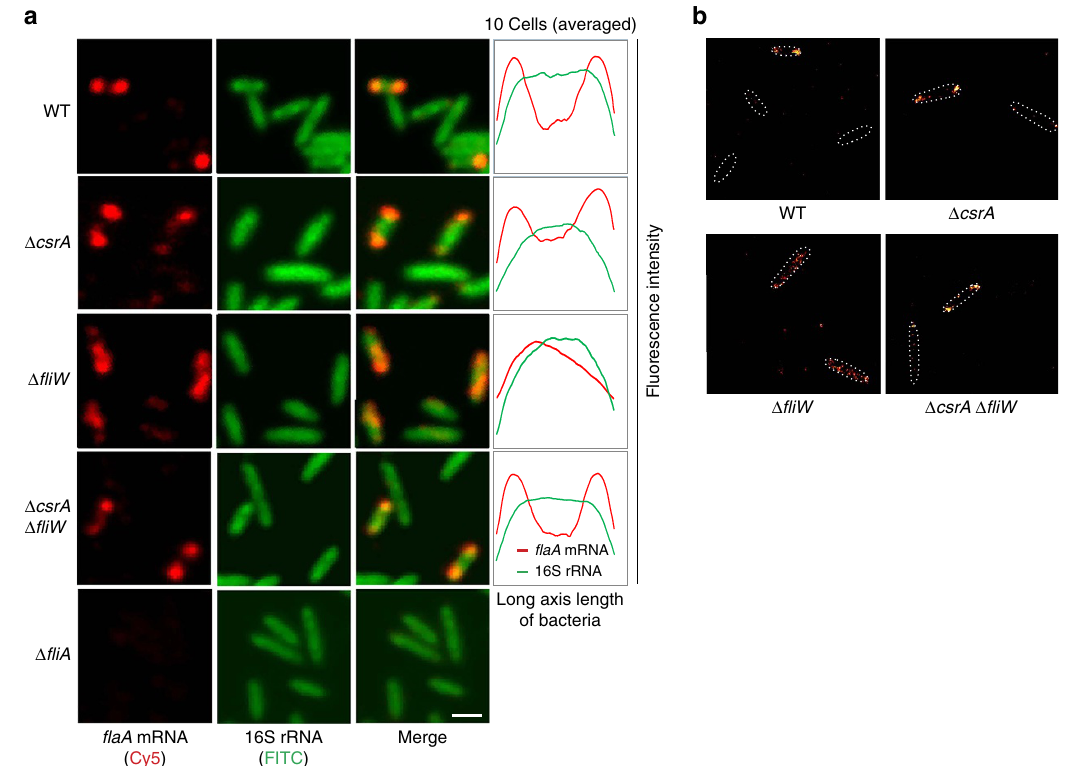
Figure 7 | CsrA and FliW influence flaA mRNA localization to the poles. ( a ) RNA-FISH analysis (Left: confocal microscopy images; Right: averaged fluorescence intensity along the long axis based on 10 cells) of 16S rRNA (green) and flaA mRNA (red) in C. jejuni NCTC11168 WT, D csrA , D fliW , D csrA / D fliW and D fliA strains in mid-log phase. FITC and Cy5 channels were merged in the microcopy images in the third lanes (scale bar, 1 m m). ( b ) Super- resolution microscopy imaging of flaA mRNA RNA-FISH (14 Cy5-labelled oligos) in the indicated C. jejuni strains using d STORM imaging. Cell boundaries from bright-field images are depicted by white dotted